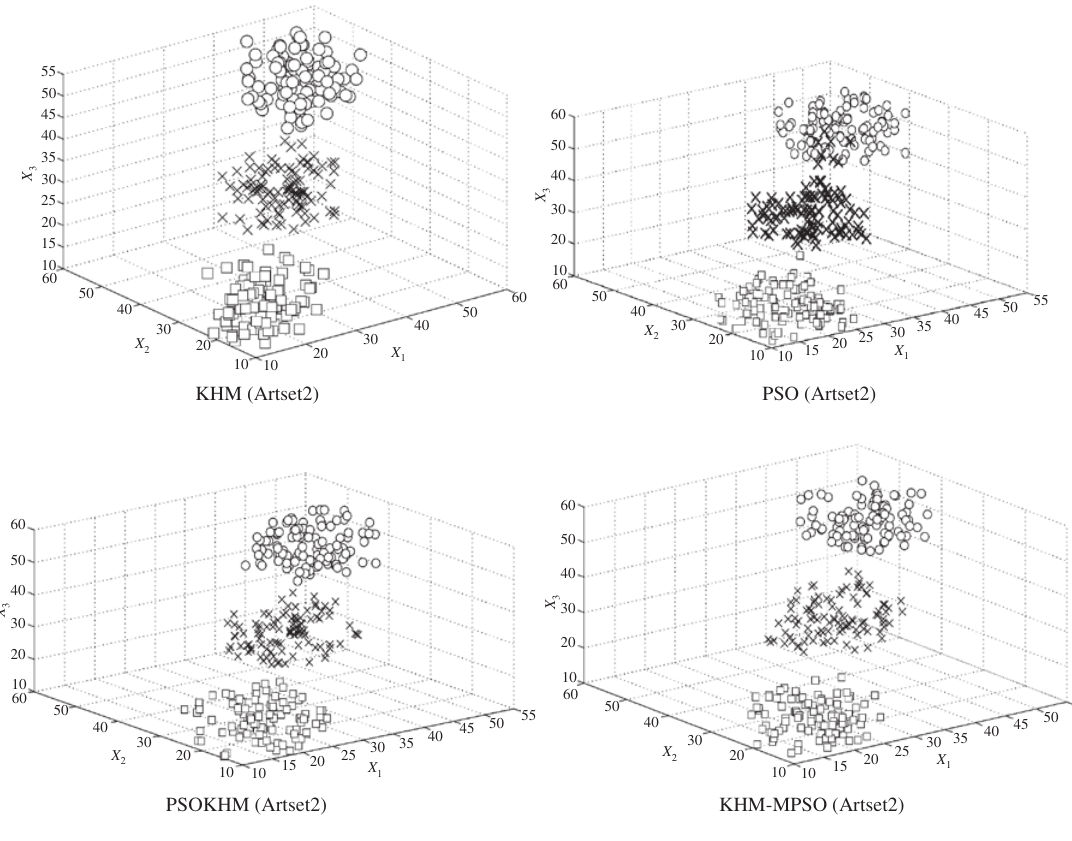
Figure 5: An Execution of KHM, PSO, PSOKHM, and KHM–MPSO Clustering Algorithms on Artset2 Data Set.